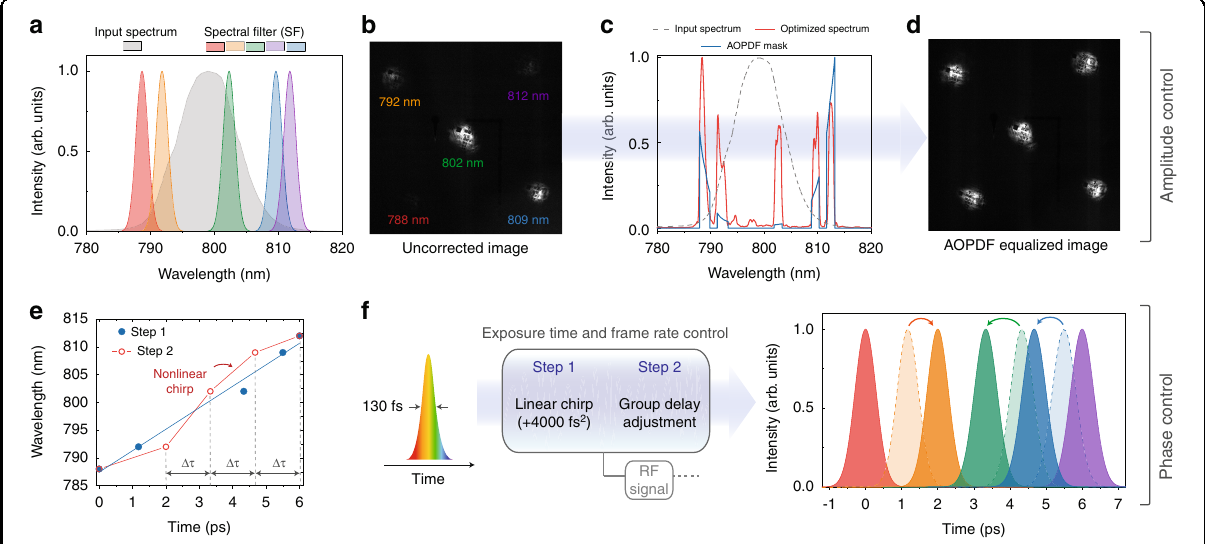
Fig. 2 AOPDF-based amplitude and phase control. a Input laser spectrum compared with the normalized transmission bands of the STAMP spectral fi lter (SF). b The convolution of the input spectrum with the SF leads to an inhomogeneous sub-pulse intensity distribution on the CCD camera and is associated with poor intensity dynamics. c Amplitude mask applied on the AOPDF (blue) and resulting optimized spectrum (red) compared with the input spectrum (dotted gray). d Resulting image with equalized intensities and optimized dynamics. These are raw images without any post-processing. e, f Spectro-temporal distributions of the illuminating pulses. Exposure time and frame rate can be independently controlled by adding a linear chirp and adjusting the group delay of each spectral component, respectively. The arrows correspond to the group delay effect on the